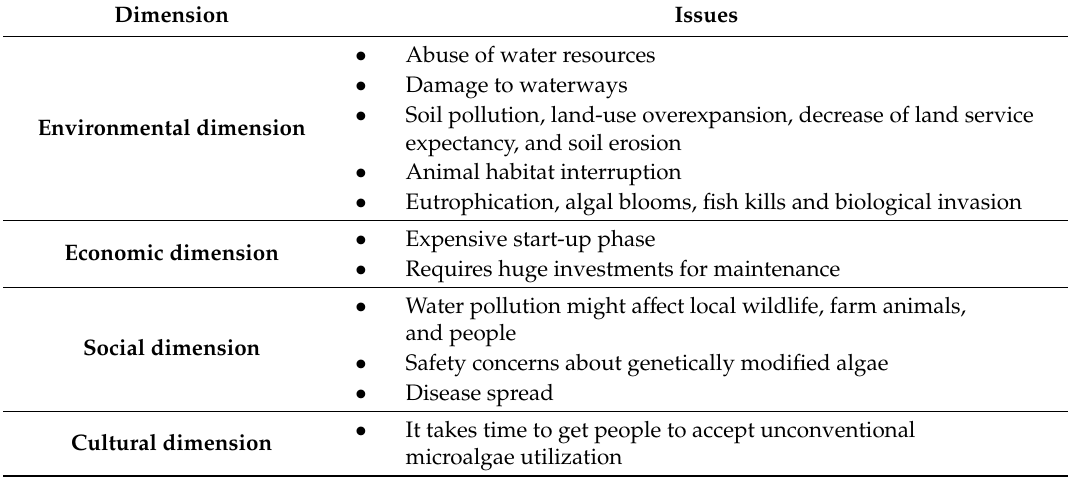
Table 4. Environmental, economic, social, and cultural e ff ects of large-scale algal oil production.